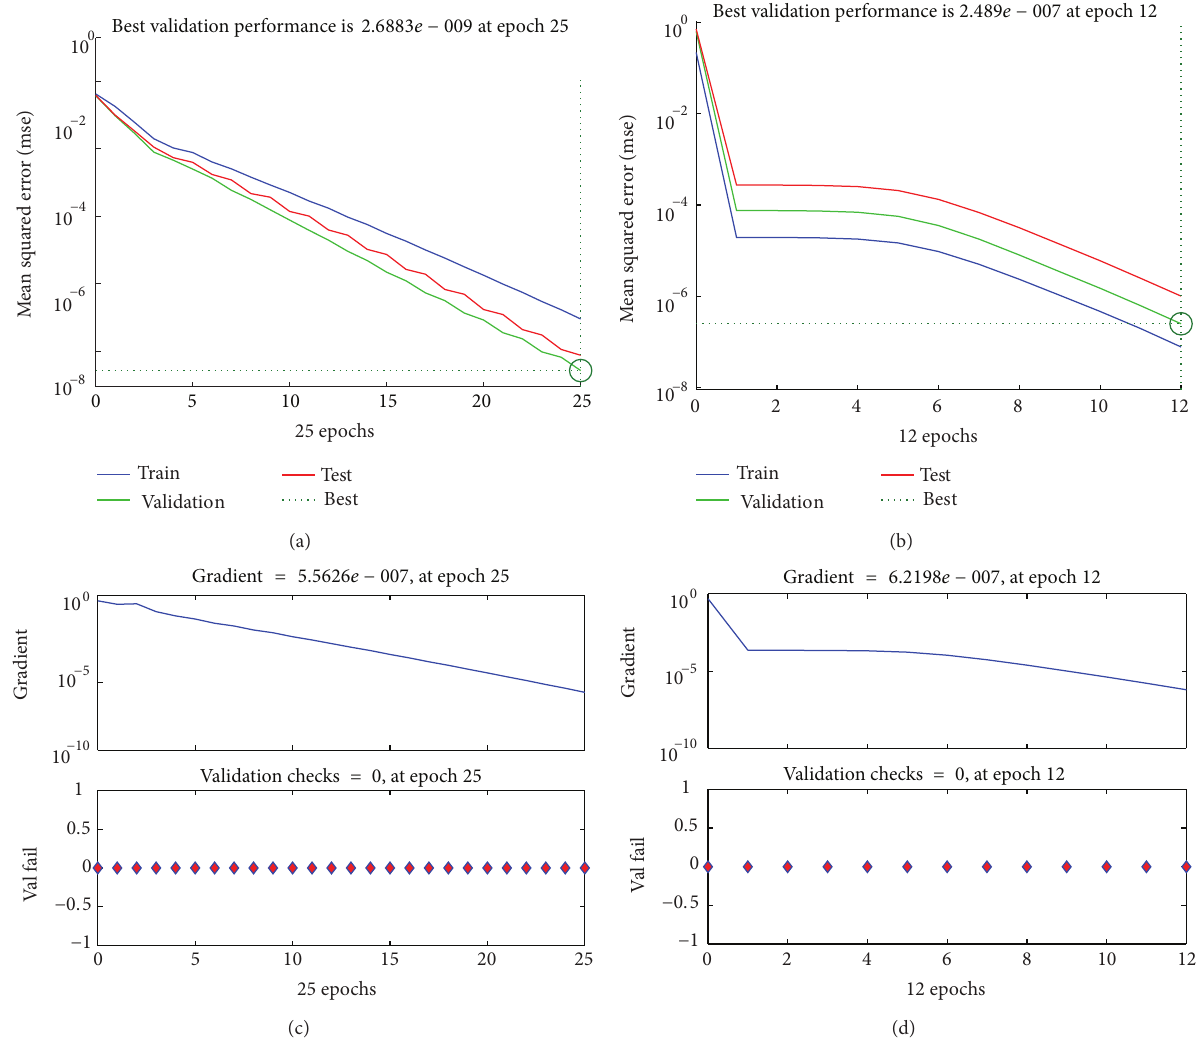
Figure 10: (a) Best validation performance of ANN. (b) Best validation performance of ANN+AP. (c) Training state of ANN. (d) Training state of ANN+AP femtocell